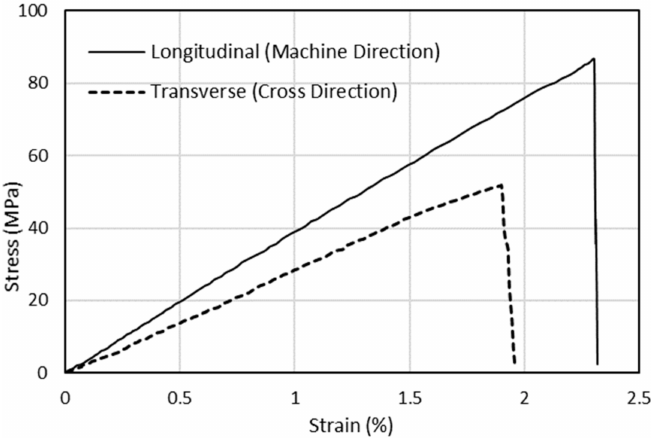
Figure A1. Tensile stress–strain curve of the Phenolic resin-based polymer Nomex